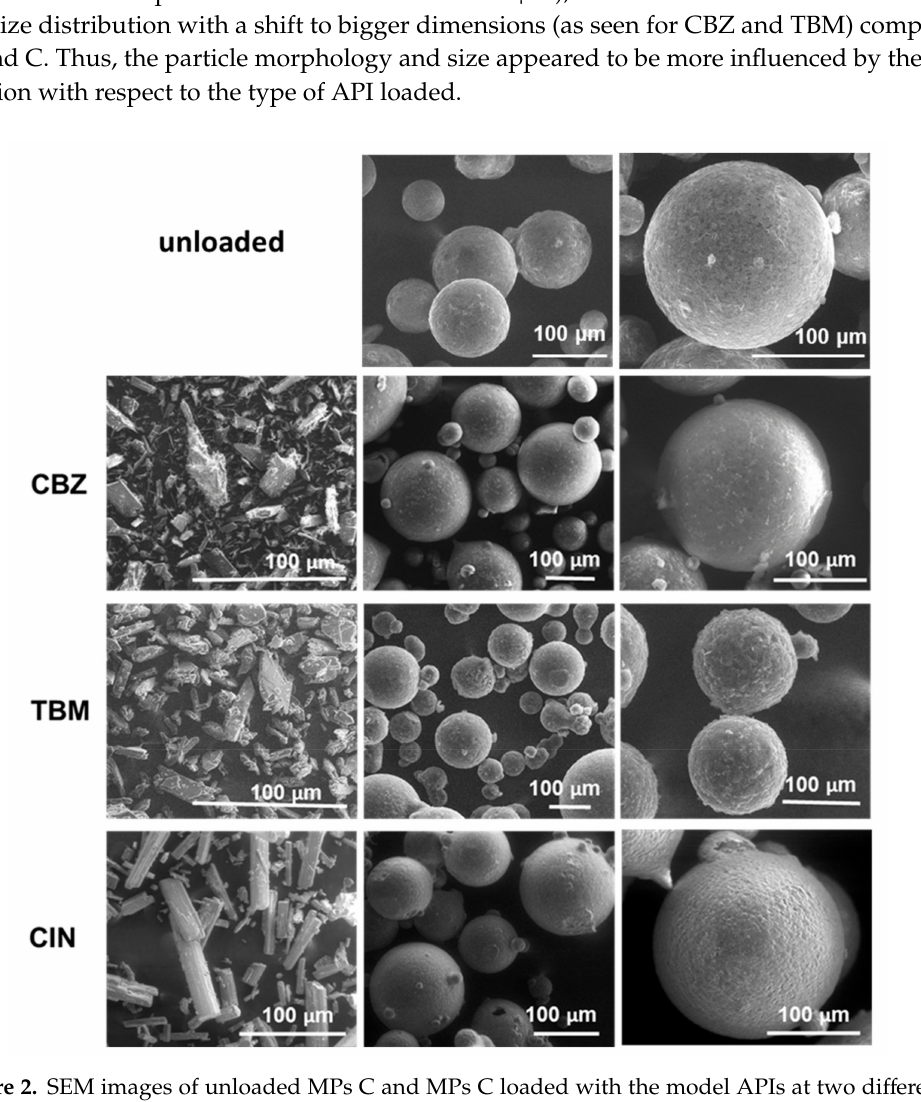
Figure 2. SEM images of unloaded MPs C and MPs C loaded with the model APIs at two di ff erent magnifications (center and right). The pure APIs are also shown